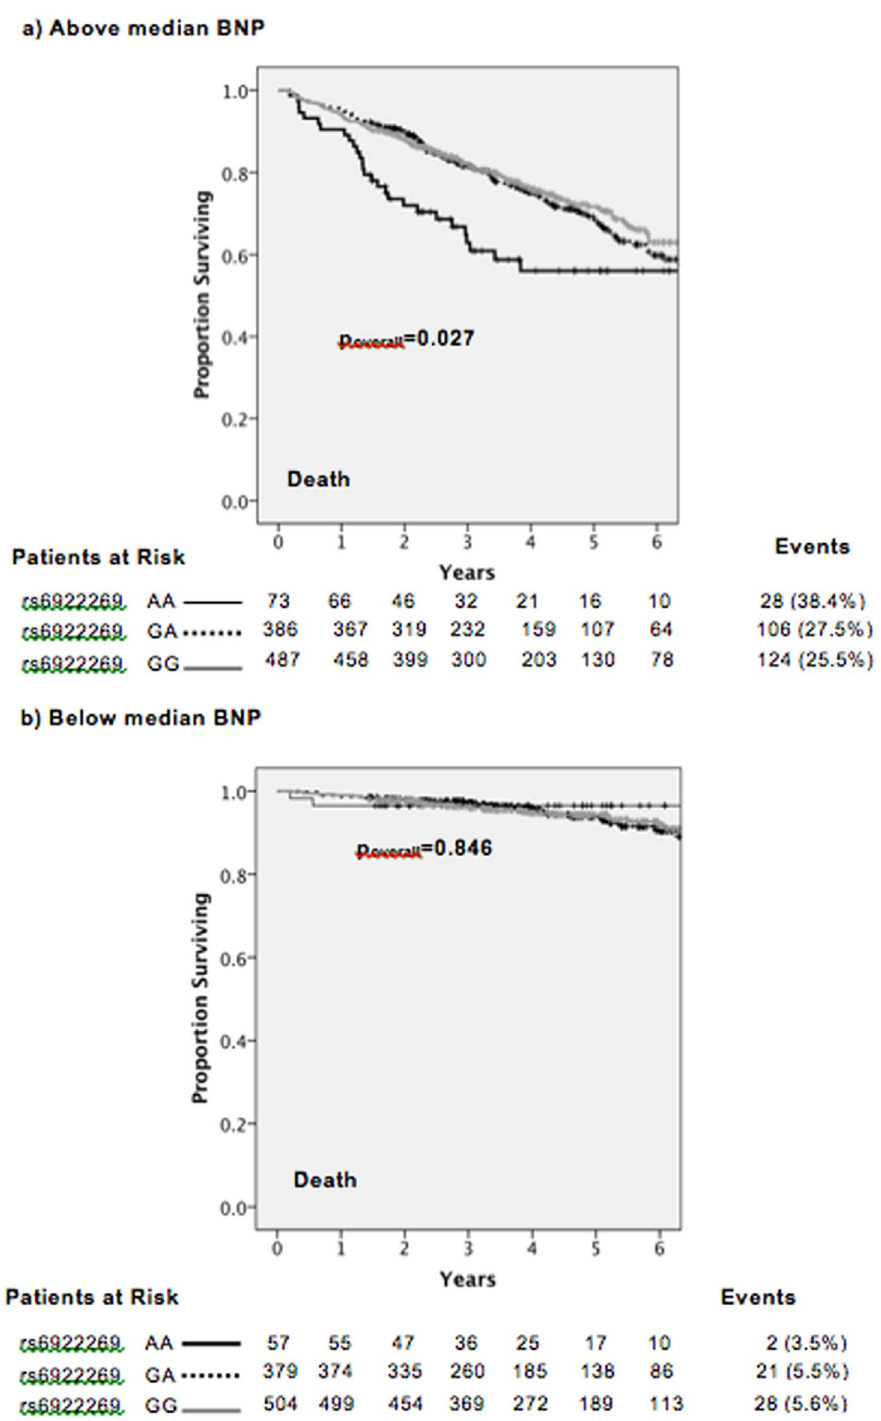
Figure 5. Kaplan-Meier survival analysis of PMI cohort patients stratified by rs6922269 genotype.